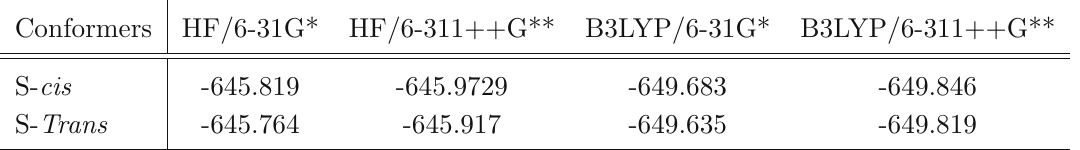
Table 1 Total energies (in Hartress) of cis and trans conformers for acetyl coumarin by DFT and ab initio